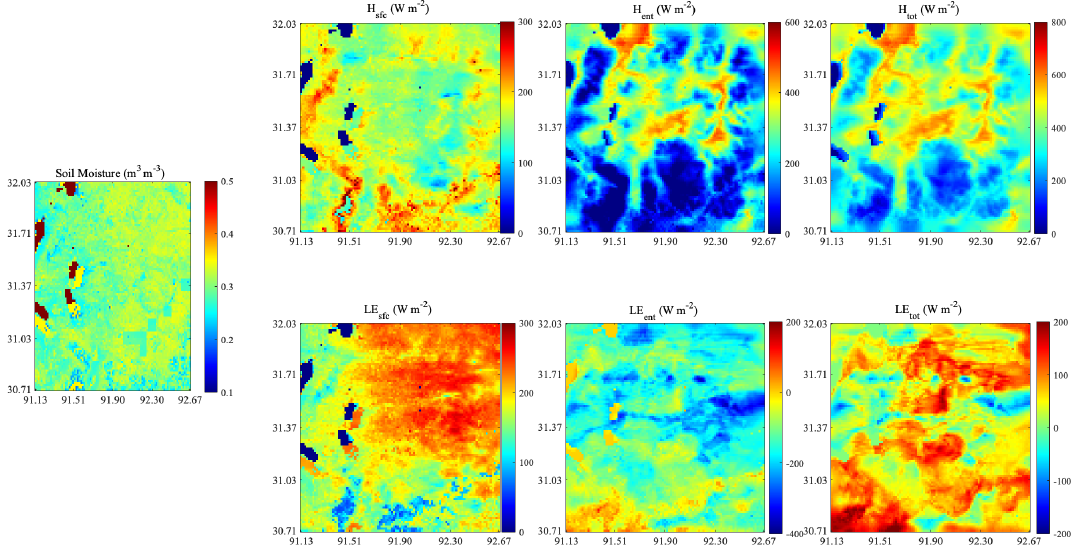
Figure 8. Spatial distributions of mean soil moisture at 0–10cm and the PBL energy budgets on 7 August 2011. Simulated using WRF with Noah-BouLac. The scale of the color map for the soil moisture is 0–0.6m 3 m − 3 in order to highlight the spatial variability in soil moisture. The soil moisture in dark red is 1.0m 3 m − 3